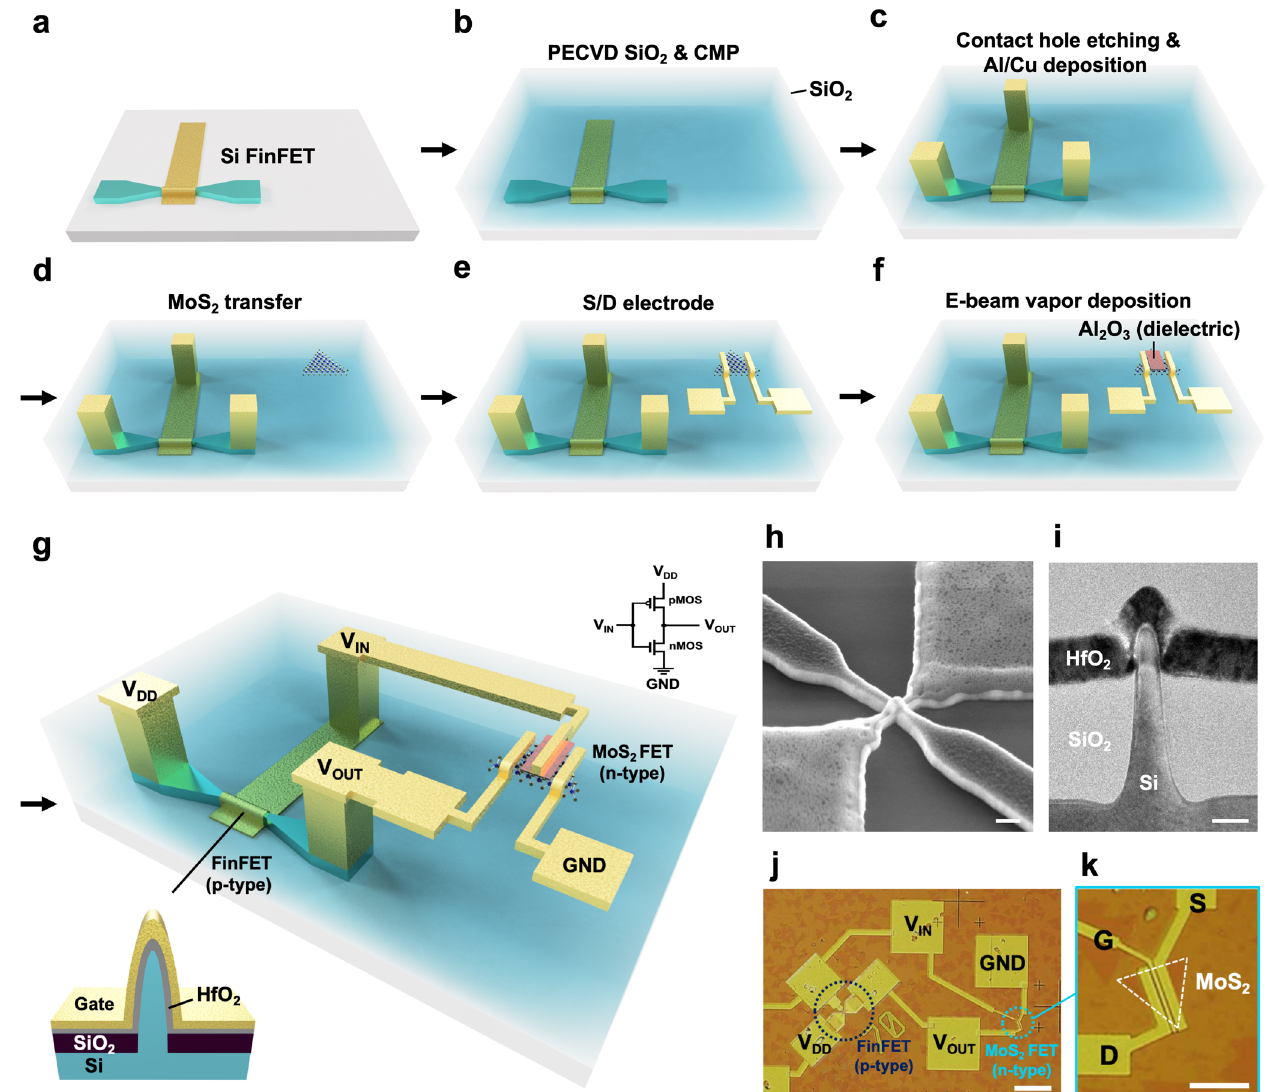
Fig. 1 Schematic and process fl ow of the 3D Si-MoS 2 CMOS inverter. a Completed Si FinFET on SiO 2 /Si substrate. b Deposition of SiO 2 via PECVD to create an intermediate layer on the FinFET for passivation, followed by chemical mechanical polishing for the thinning and fl attening of the SiO 2 layer. c Building the monolithic intertier vias (MIVs) by employing contact hole etching and e-beam vapor deposition. d Transferring the monolayer MoS 2 triangles on the SiO 2 layer. e Fabrication of source/drain electrodes connected to MoS 2 using e-beam lithography and e-beam vapor deposition. f E-beam vapor deposition of Al 2 O 3 dielectric as the top-gate on MoS 2 . g Schematic of a CMOS inverter fabricated by vertically integrating a p-channel Si FinFET and an n-channel monolayer MoS 2 transistor. The inset shows the cross- sectional structure of the Si FinFET. h SEM image of the Si FinFET. Scale bar: 100 μ m. i TEM image showing the cross-section of Si FinFET. Scale bar: 25 nm. j Optical image showing the top view of the fabricated 3D CMOS inverter. Scale bar: 100 μ m. k Zoom-in image showing the MoS 2 FET in k . Scale bar: 10 μ